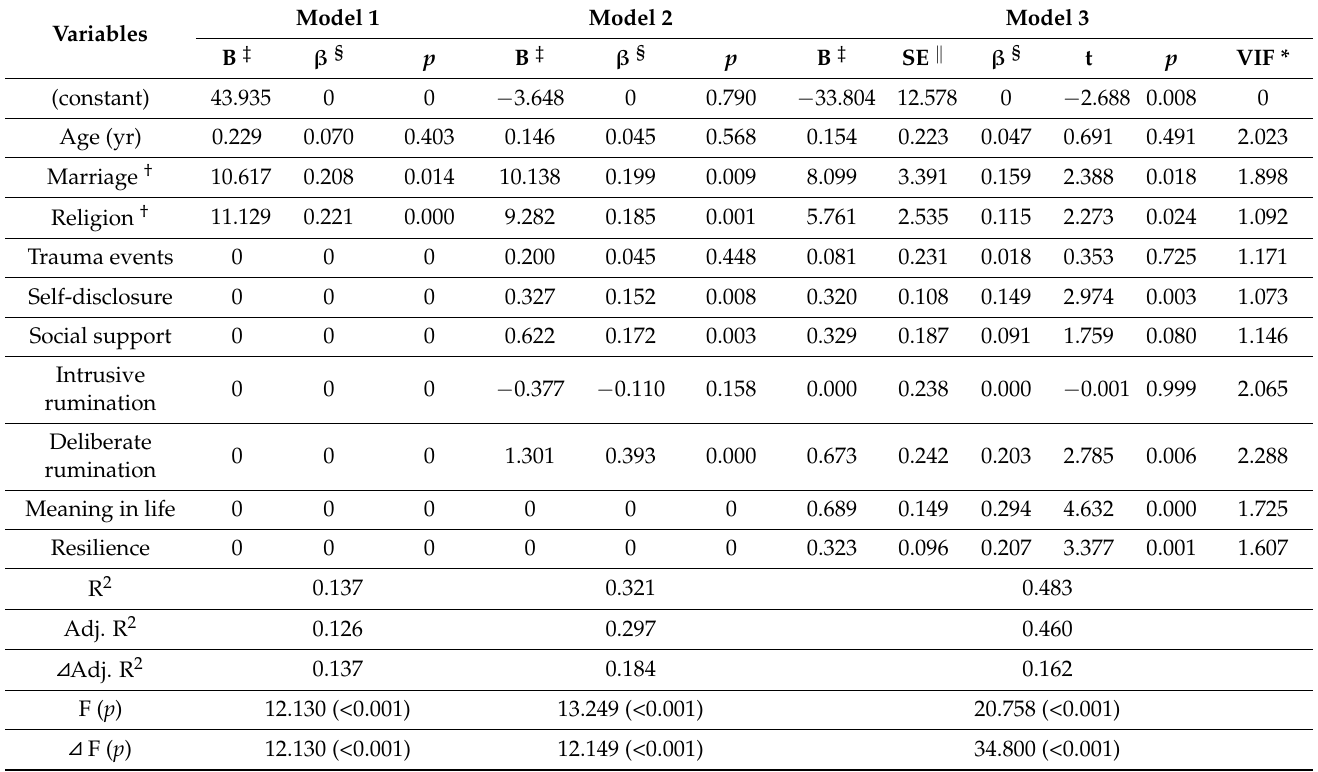
Table 4. Factors Affecting Post-Traumatic Growth (N =